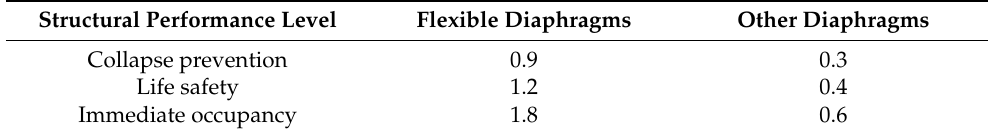
Table 2. Coefficient χ 1 for calculation of the out-of-plane all